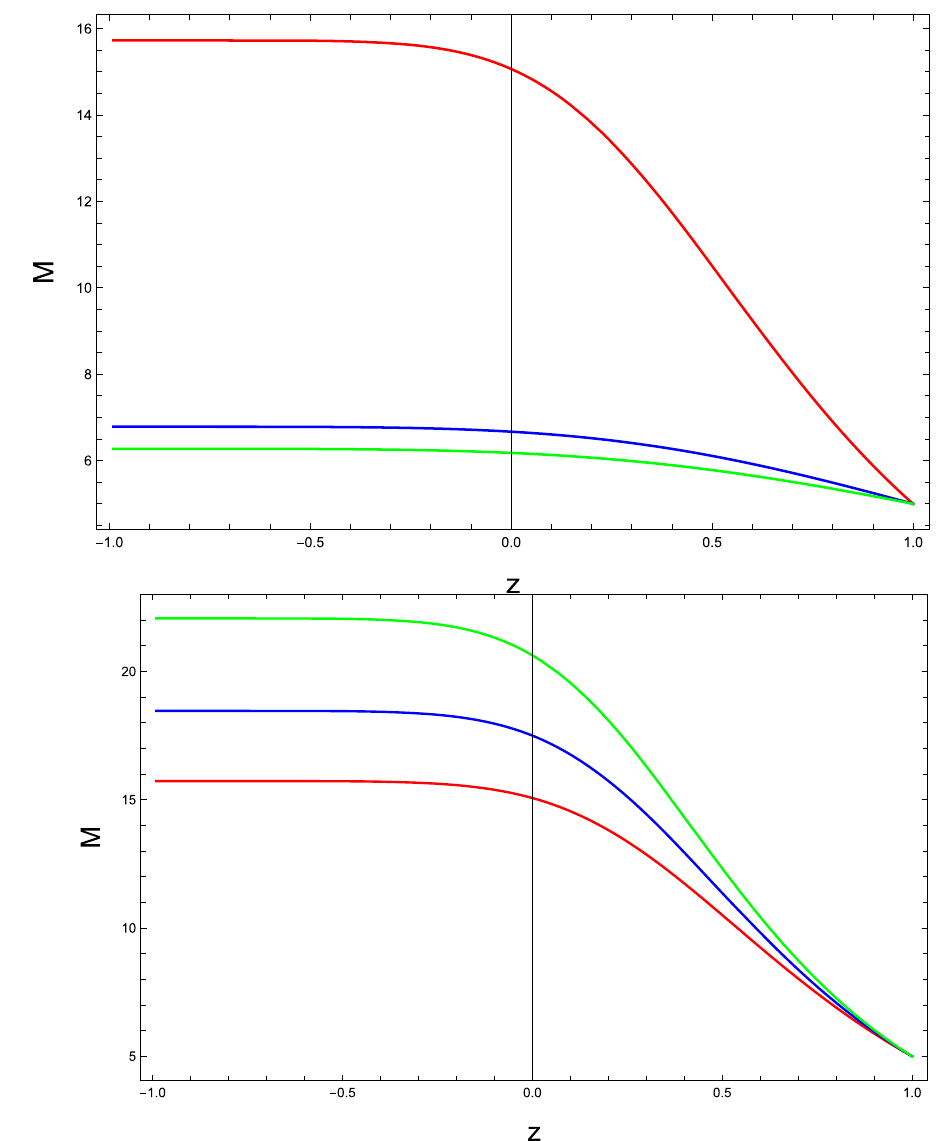
Fig. 2 Evolution of PBH mass M ( z ) with redshift z for different λ and ω = 0 . 5. Here λ = 0 . 00007 (red), λ = 0 . 00008 (blue) and λ = 0 . 00009